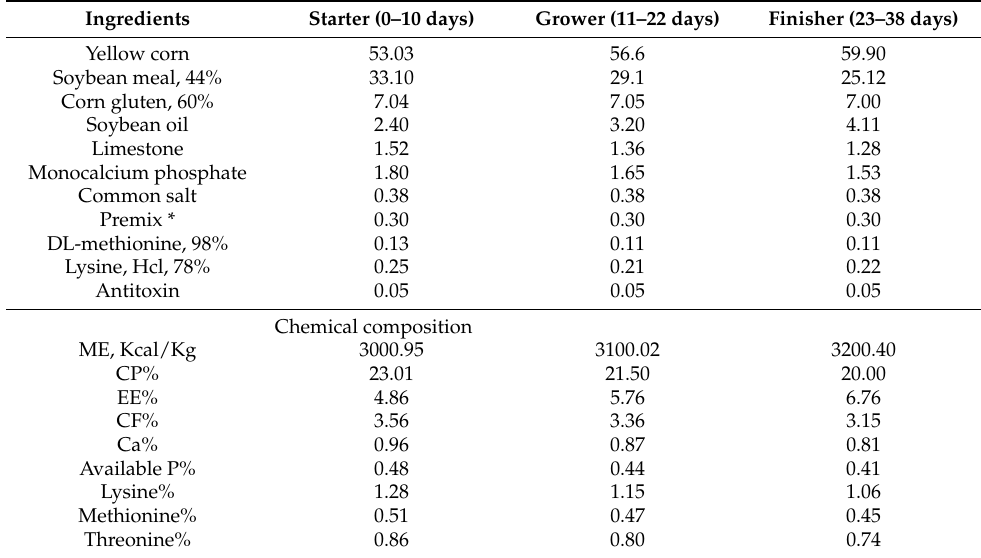
Table 1. Ingredients and composition (%) of the basal